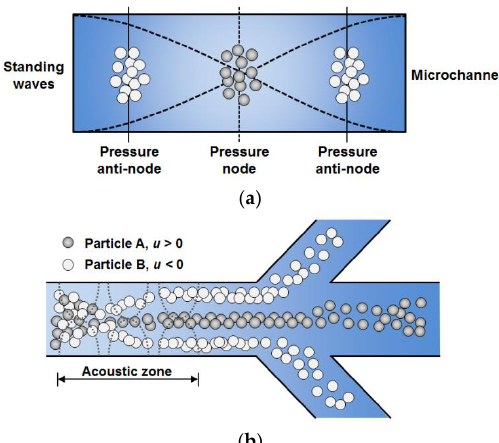
Figure 5. Acoustophoretic motion of suspended particles in an acoustic wave field. ( a ) Movement of particles by an acoustic standing wave with varying pressure profiles. ( b ) Density- and compressibility-based separation of particles by acoustophoresis. Reproduced from [108], with the permission of The Royal Society of Chemistry (2007).